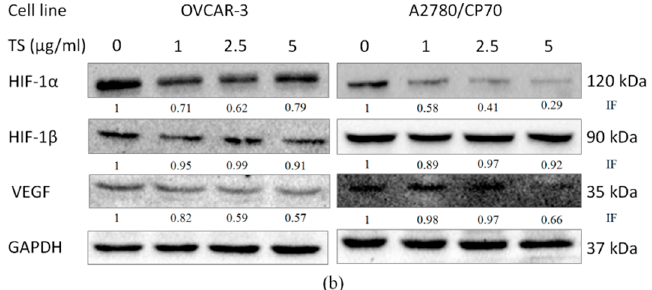
Figure 5. Effects of TS on anti-angiogenesis via decreased VEGF secretion and protein expression levels of VEGF and HIF-1 α . ( a ) The protein secretion of VEGF in TS-treated OVCAR-3 and A2780/CP70 cell culture supernatant was detected via VEGF ELISA assay. Lower case letters (a, b, etc.) mean a significant differences among different treatments ( p < 0.05); ( b ) The protein expression levels of HIF-1 α , HIF-1 β and hVEGF with 0 to 5 µg/mL treatment TS for 24 h analyzed by Western blotting. “IF” means impact factor and represents the Western blotting signals were quantified and normalized to the loading control GAPDH.